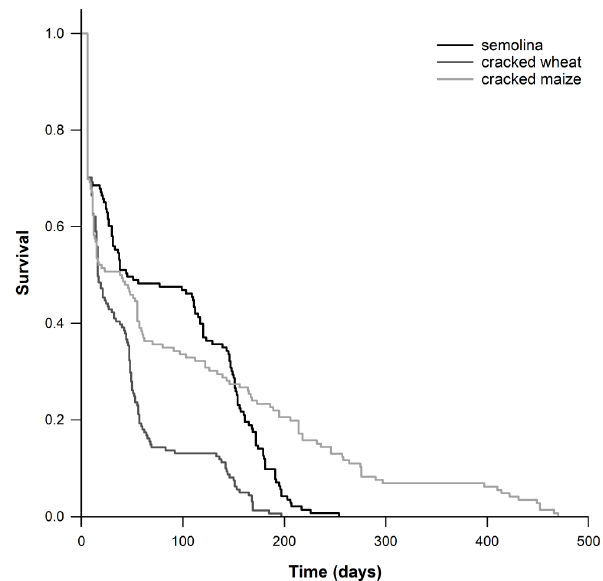
Figure 1. Survival curves of Tribolium castaneum fed on three commodities. Table 3. Values of net reproductive rate ( R 0 ), intrinsic rate of increase ( r m ), finite rate of increase ( λ ) and mean generation time ( T ) of Tribolium castaneum (mean, 95% C.I.) fed on three commodities. Where dashes exist no demographic parameters were calculated.